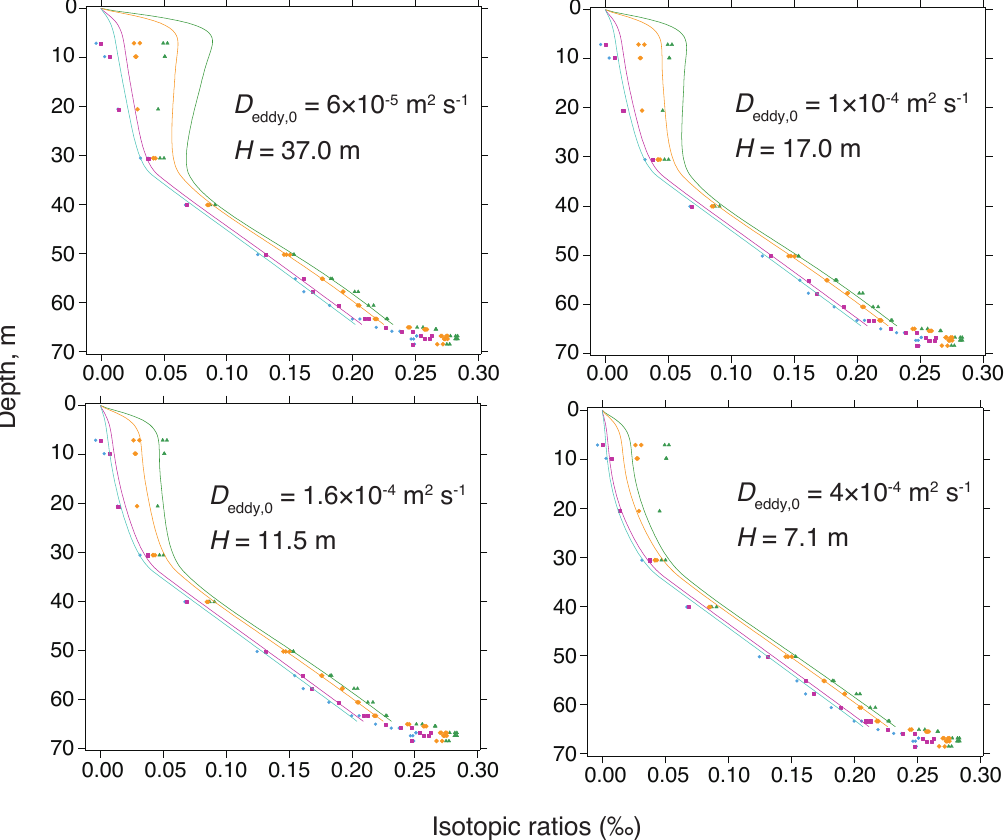
Fig. 5. Model results with different combinations of surface eddy diffusivity and scale depth. The eddy diffusivity profiles were kept constant in time for all